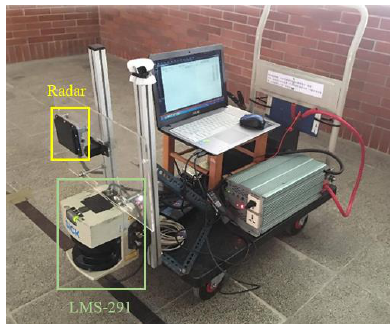
Figure 4. Equipment setup for radar tracking system verification.